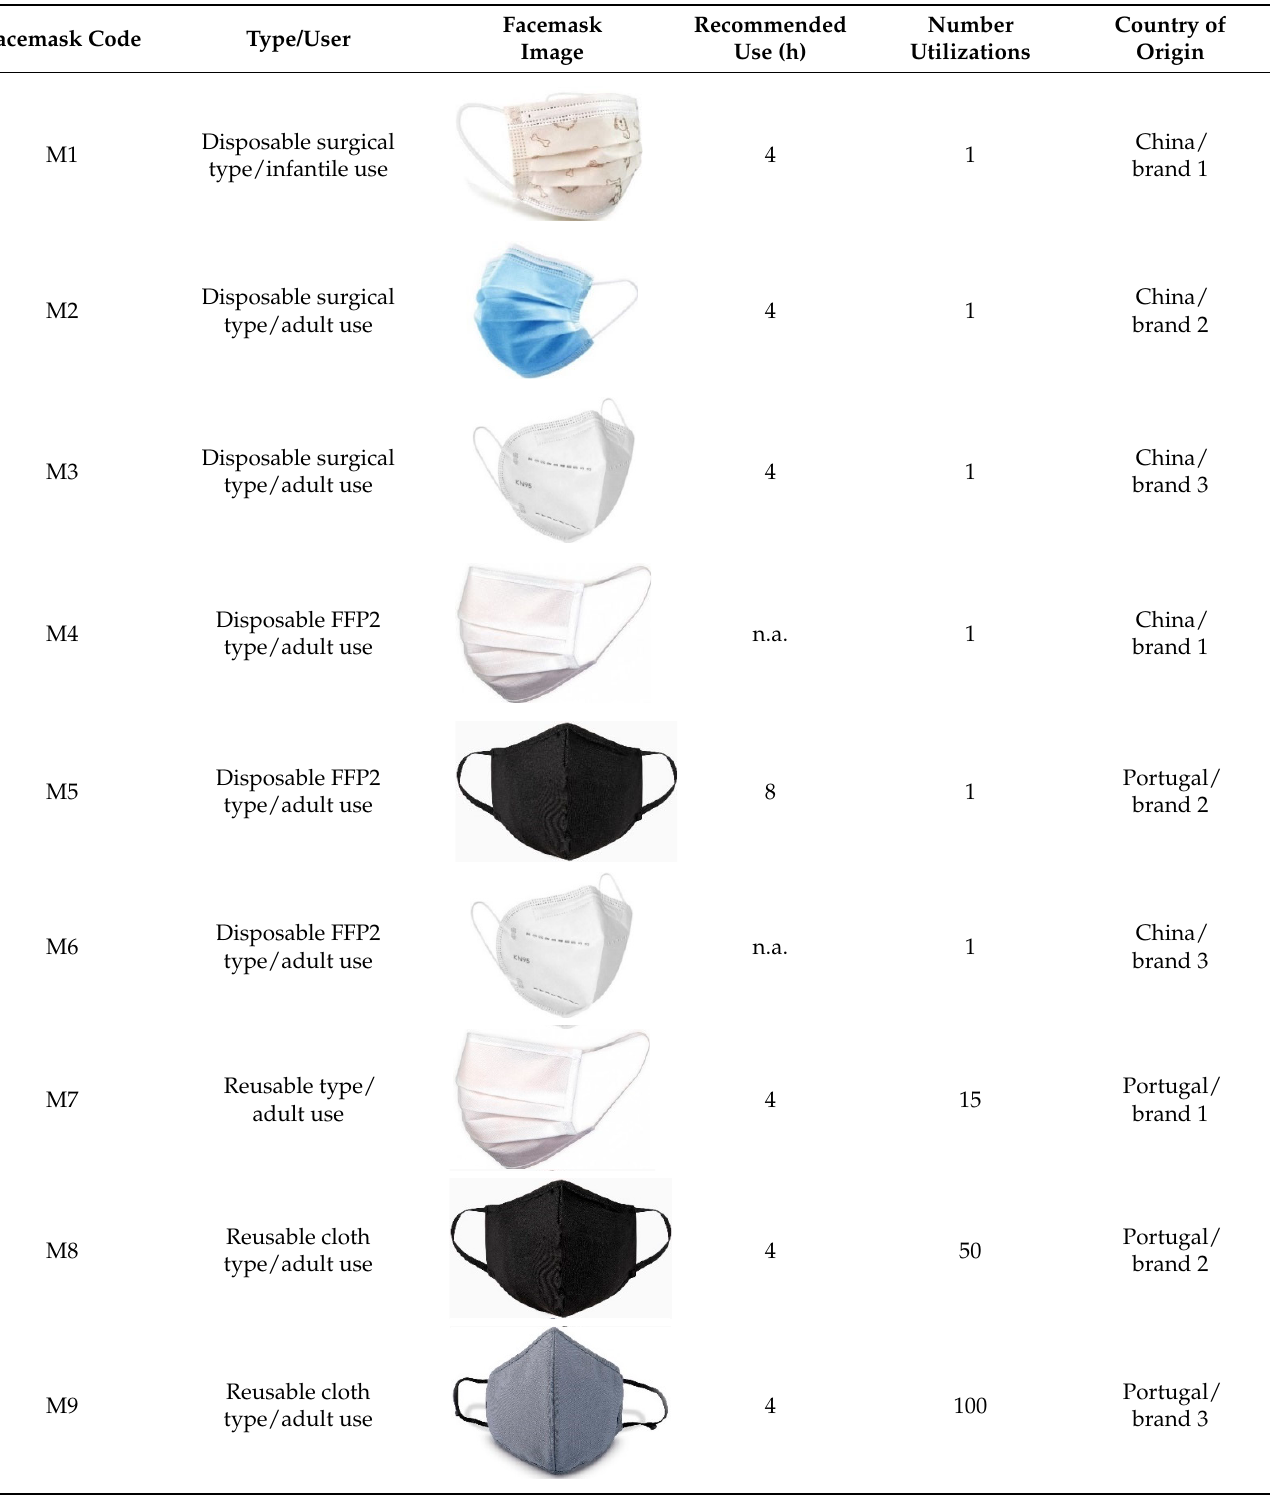
Table 2. Characteristics of the nine facemasks analyzed in this work of three different types: surgical